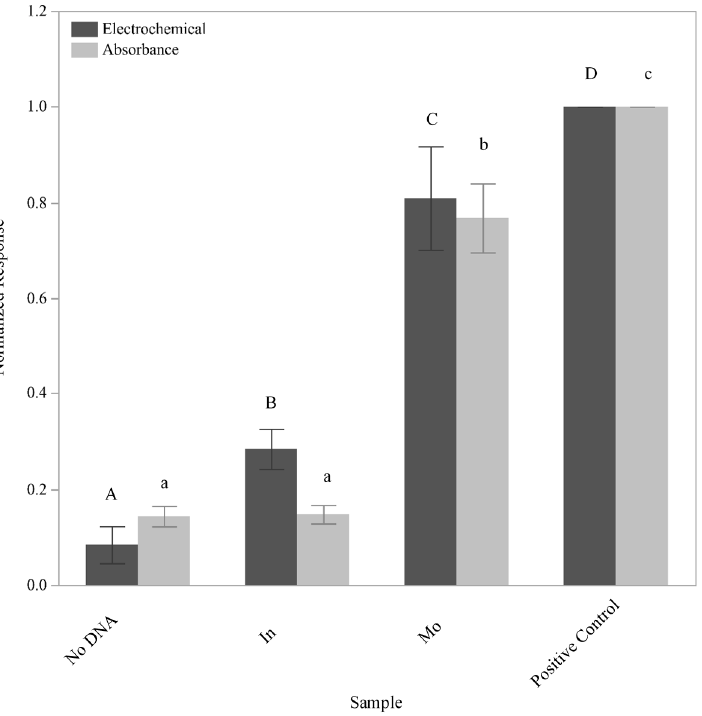
Figure 4. Specificity of the sensor for L. monocytogenes . Upon exposure of the sensor to a solution containing fragments of 10 − 7 M 16S rDNA from either L. innocua (In) or L. monocytogenes (Mo), the resulting normalized responses were determined using both electrochemistry (dark gray bars) and absorbance (light gray bars). Exposure of the sensor to buffer only (no DNA) and the direct application of the detection oligo were used as controls. The mean response of three independent trials is plotted with the standard deviations and statistical differences amongst samples noted by the connecting letters report. Levels not connected by the same letter are significantly different.